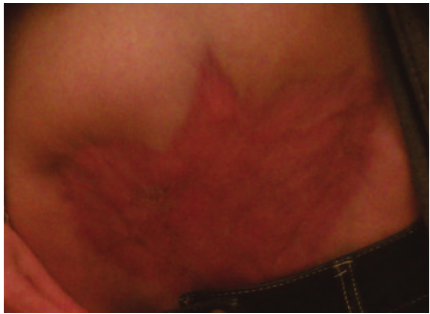
Figure 5: Multiple reconstructive surgeries have resulted in com- plete closure of her anterior abdominal